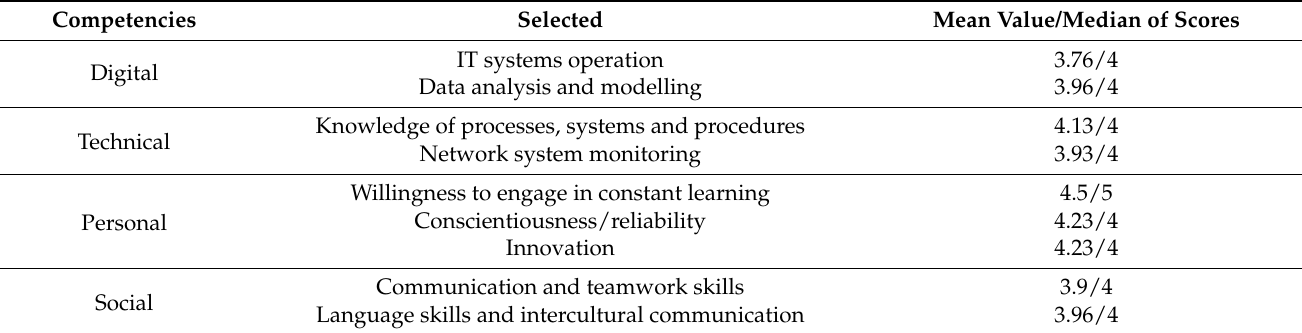
Table 4. The most popular competencies in the student